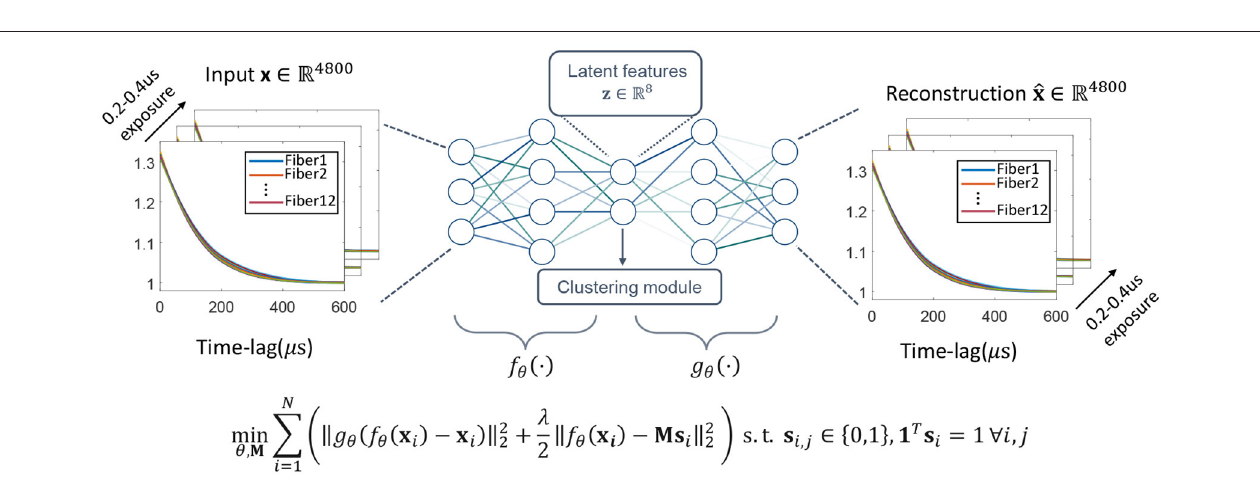
FIGURE 4 | Proposed deep clustering method for zero-shot decorrelation event classification. The network contains a stacked auto-encoder that transfers the input data into a latent low-dimension space, then reconstructs the input data from the latent features. A clustering module is used to impact the network weights update to form a classification friendly low-dimension space. Overall, the network is trained with the loss function at the bottom of the figure, with all the variables explained at the end of the Section 2.2.